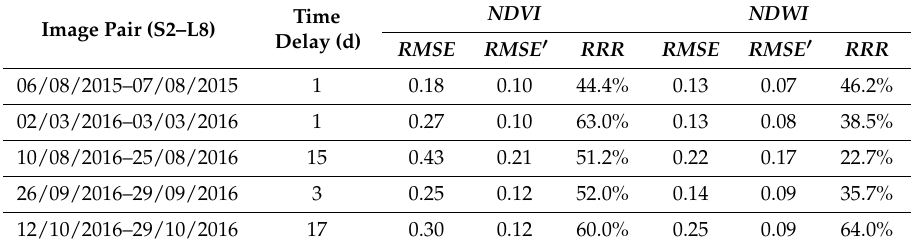
Table 8. RMSE s of NDVI / NDWI differences from S2 and L8 imagery before ( RMSE ) and after ( RMSE (cid:48) ) bias removal. RMSE reduction rate ( RRR ) is the amount (%) of improvement determined by bias